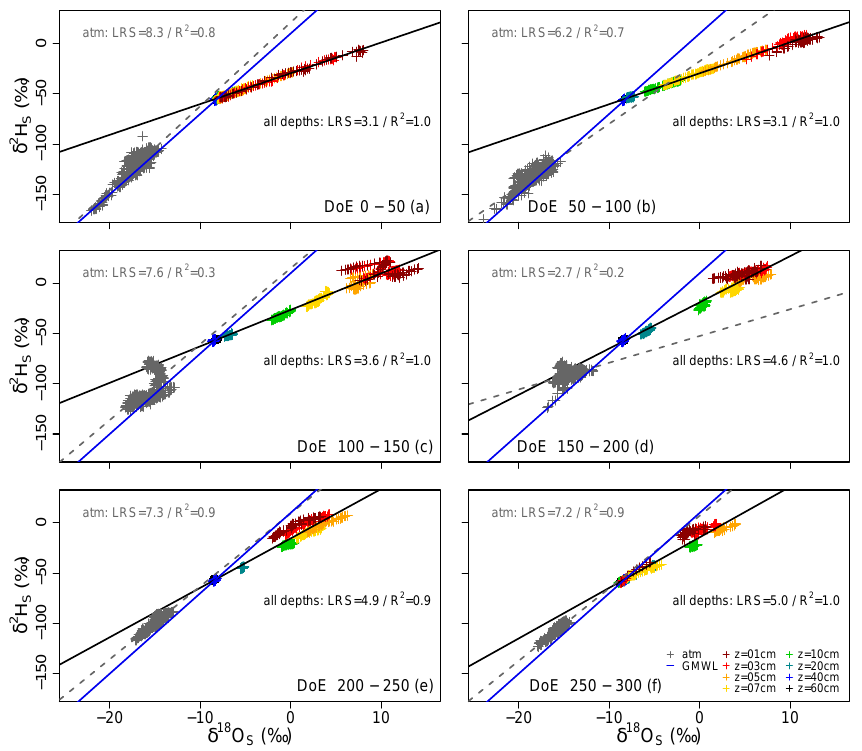
Figure 6. Linear regressions (gray dotted line) between laboratory atmosphere water vapor δ 18 O and δ 2 H [‰ VSMOW] and between soil water δ 18 O and δ 2 H (solid black line). Each plot represents data from 50 consecutive days of experiment (DoE). Global meteoric water line (GMWL; defined by δ 2 H = 8 × δ 18 O + 10, in blue dotted line) is shown on each sub-plot for comparison. Coefficient of determination ( R 2 ) as well as the slope of the linear regressions (LRS) are